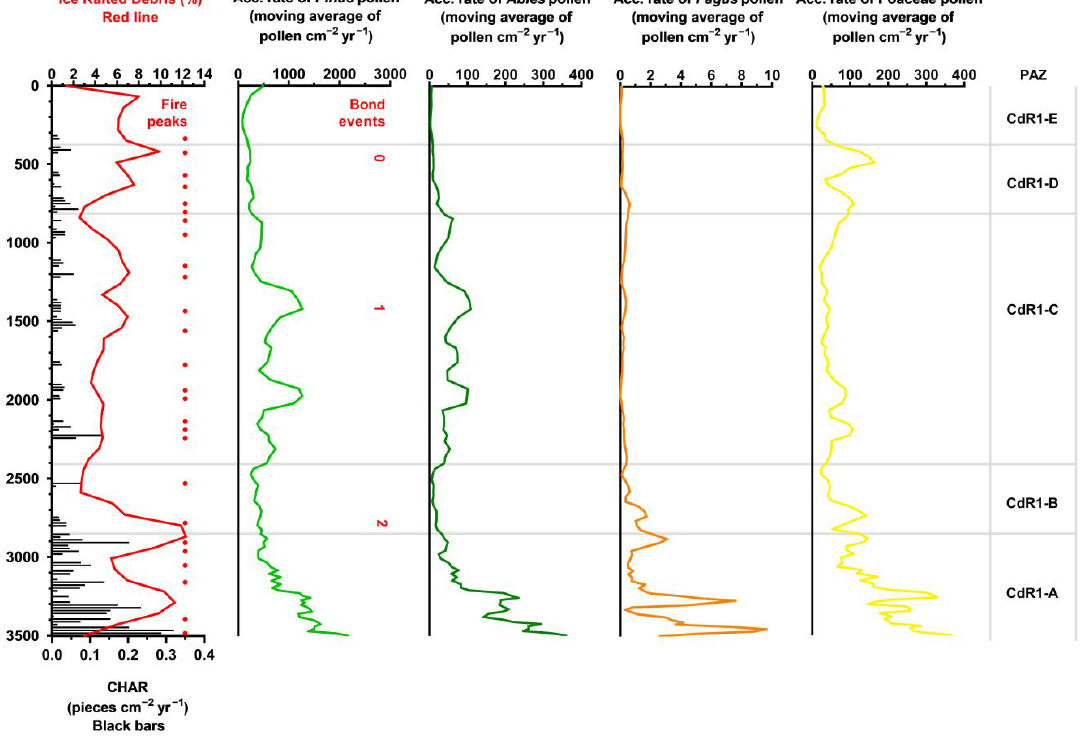
After the late Roman forestry peaks of the previous period, a sharp decline in tree taxa began. In particular, Pinus percentages dropped to values below 30%, their lowest for the sequence. Abies also registered gentler declines. In contrast, other taxa significantly increased. Betula registered the highest values of the whole core at close to 15%. Corylus and Alnus also increased, although they did not recover the values exhibited during the Bronze Age. Deciduous and evergreen Quercus did not seem to be particularly affected by the arboreal decline either, showing modest percentage increases. Mention should be made of Olea , an abundantly planted taxon originating from the south-Pyrenean plains and which around 800 cal yr BP experienced a remarkable increase. Since then, it has re- mained much the same with small ups and downs. In the 16th century, there was an in- tense rebound of the Pinus pollen and consequently the pollen percentages of other taxa rose. All tree pollen fell rapidly again throughout the 17th century CE. Shrubs and herba- ceous taxa maintained or increased their percentages, as can be seen in the Ericaceae, Ar- temisia , Poaceae, cereals, Plantago , and Apiaceae curves. In particular, the Poaceae accu- mulation rate registered an important increase during this PAZ (Figure 7). Cereals dis- played their maximum expansion coinciding with the major forest decline around the 15th